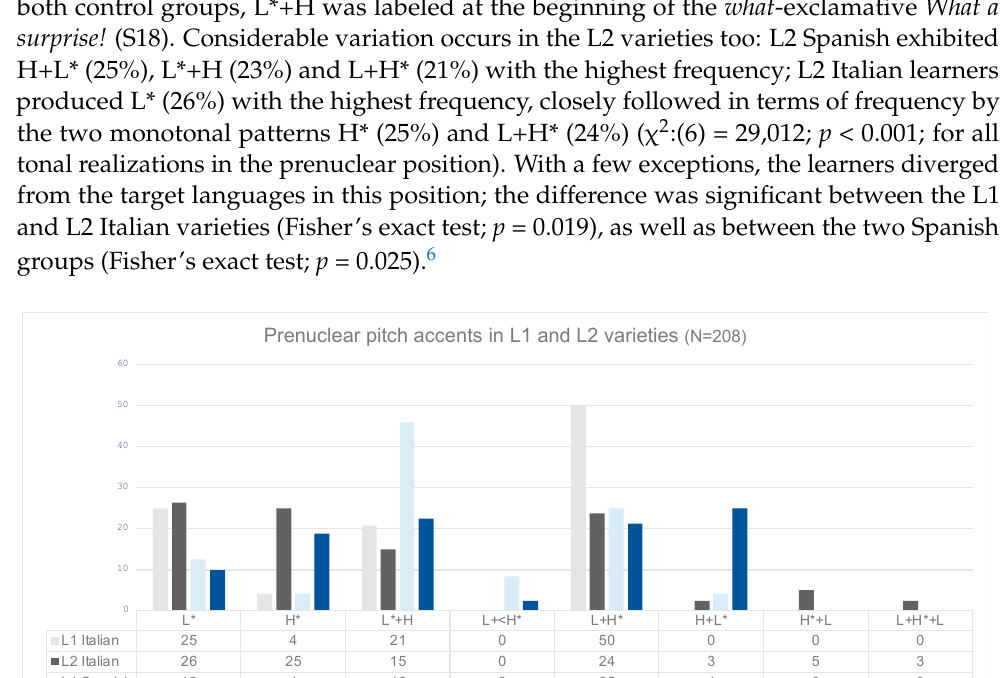
Figure 15. Tonal patterns of prenuclear pitch accents found in all L1 and L2 data (in %). The results for boundary tones (IP) show much less variation. 97% of all non-neutral sentences were produced with an L% boundary tone in L1 Italian, followed by L2 Italian (94%) and L2 Spanish (86%). As expected, the non-neutral statements in L1 Spanish show a different pattern here (Section 2.3): 64% of the statements were produced with L% boundary tones, 19% with HL% and 14% with L!H% (Figure 16). No significant differences were obtained for L1 and L2 Italian varieties (Fisher’s exact test; p = 0.064) and between L2 Italian and L2 Spanish (Fisher’s exact test; p = 0.884). The only significant difference was found between L2 Spanish learners and L1 Spanish controls (Fisher’s exact test; p <